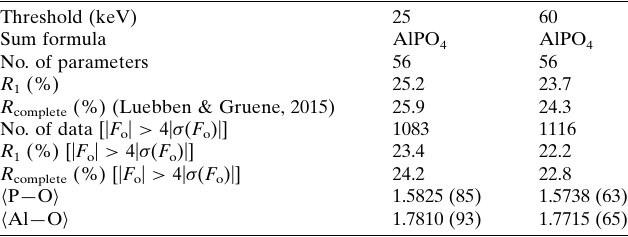
Table 1 Data statistics for SAPO-34. The resolution shells given are the full range, the low-resolution shell and the high-resolution shell. Note that the crystals diffracted beyond the edge of the